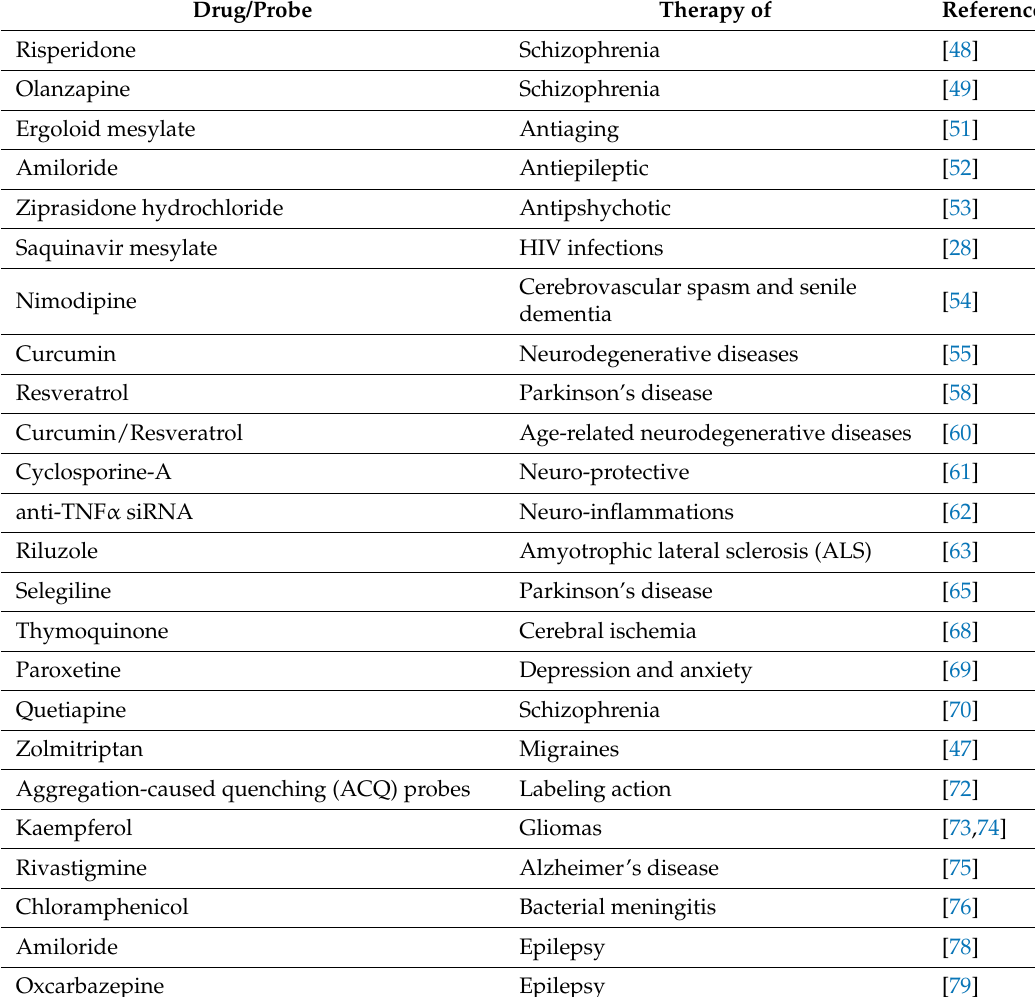
Table 2. Nanoemulsions designed for nose-to-brain delivery, and classification based on the